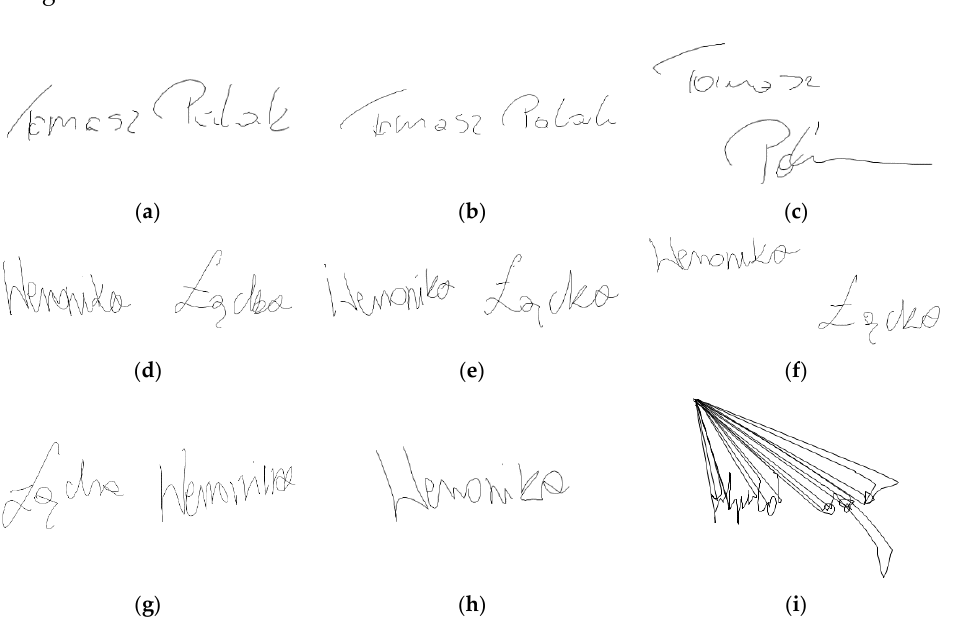
Figure 5. Selected mistake types found in the dataset. Person 1 provided two correct signatures ( a ) and ( b ), but in ( c ) wrote their surname below the first name instead of to the right. Similarly, Person 2 correctly provided signatures ( d ) and ( e ) but wrote their surname in a different place in ( f ) and swapped first name ’ s and surname ’ s positions in ( g ). Lastly, they only provided the first name, without a surname, in ( h ). Example ( i ) from Person 3, on the other hand, shows anomalies intro- duced by erroneous touch events registered during signature acquisition.